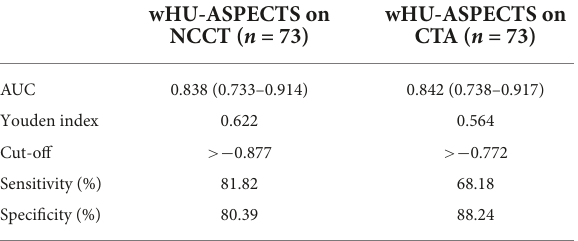
TABLE 4 ROC analysis of attenuation changes on NCCT and CTA for classification of ischemic core ≥ 70 ml. wHU-ASPECTS on NCCT ( n = 73)